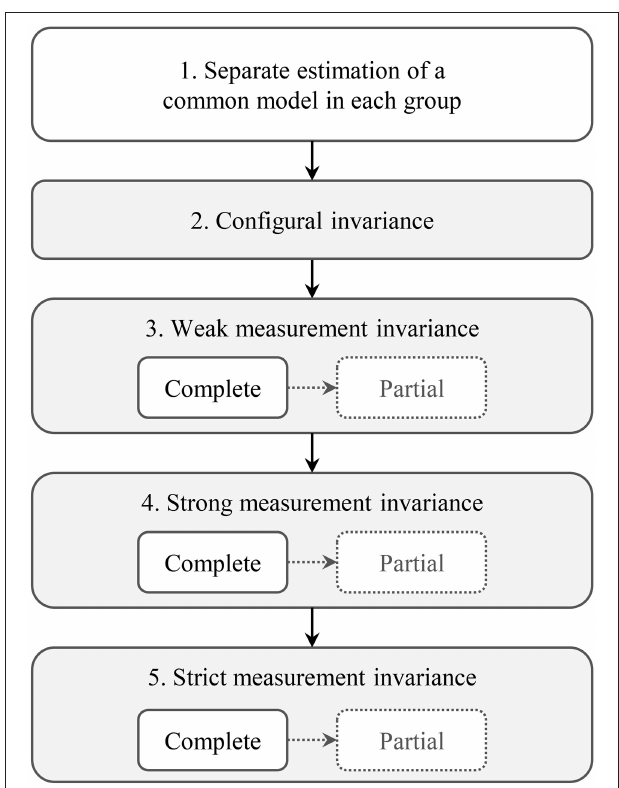
FIGURE 1 | Steps of the measurement invariance